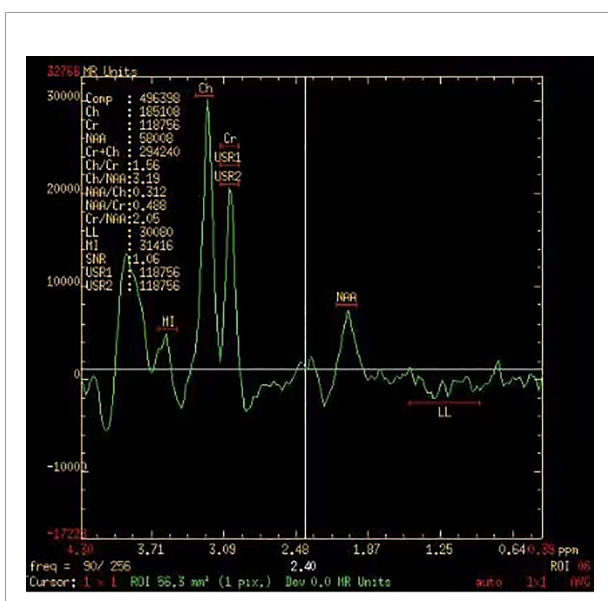
FIGURE 3 | Magnetic resonance spectroscopy imaging of a 66-year-old women with NSCLC. NSCLC, non-small cell lung